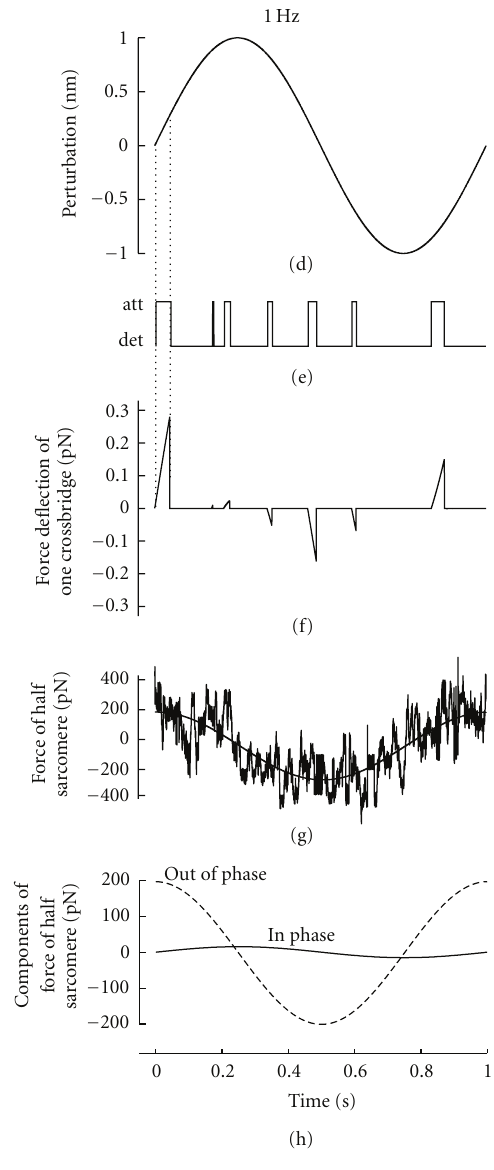
Figure 3: Schematic representation of computer-generated elastic and viscous moduli. (a)–(c) Random numbers generated from various ( t ) (one example shown in (a)) were used to dictate the attachment times, t att , of a virtual crossbridge. (b) shows an example PDF t att ( t ), with p = 2 and β = 48, used to dictate the intermittent times of attachment and detachment sequence. (c) illustrates the PDF t det detachment. (d) A sinusoidal length perturbation with amplitude 1nm was used to simulate an externally applied length perturbation. This example is at 1Hz. (e) An example series of successive crossbridge attachments and detachments would be subject to the length perturbation. (f) The length change that occurs during the time of attachment results in a force deflection. (g) The sum of these force deflections from 20,000 crossbridges is then fit to a sinusoidal (solid smooth line). (h) The magnitude of the component of the fitted sinusoid in phase with the length perturbation represents the elastic modulus at this frequency, the magnitude of the component out of phase represents the viscous